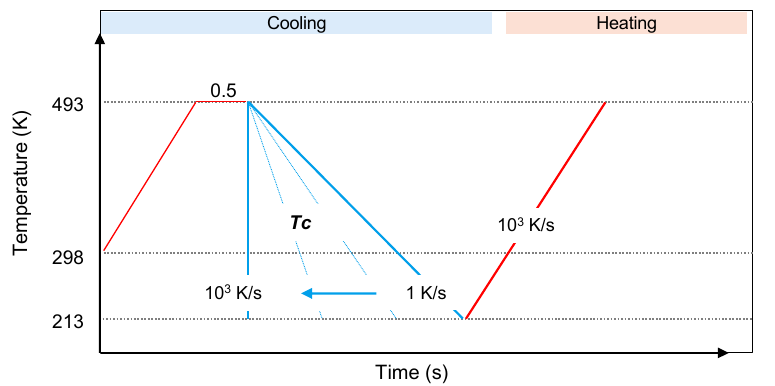
Figure 1. Temperature–time profile used in the analysis of structure formation at different cooling rates. The final, red-colored heating segment served for analysis of the fraction of crystals formed in the prior cooling step.